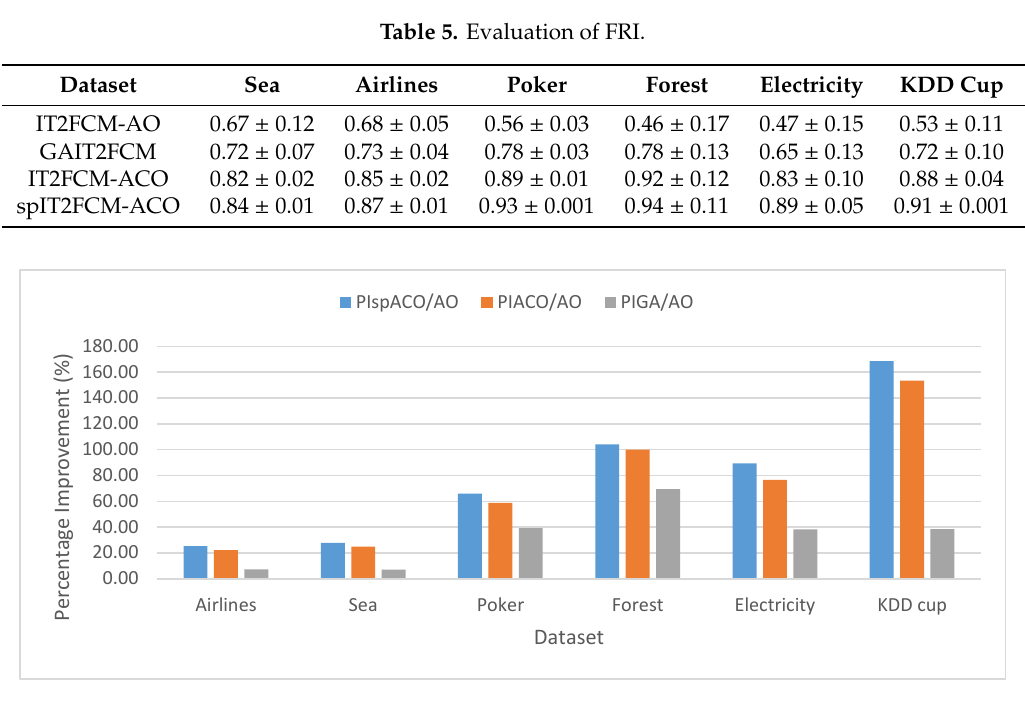
Figure 4. Analysis of PI for FRI in different algorithms over IT2FCM-AO.